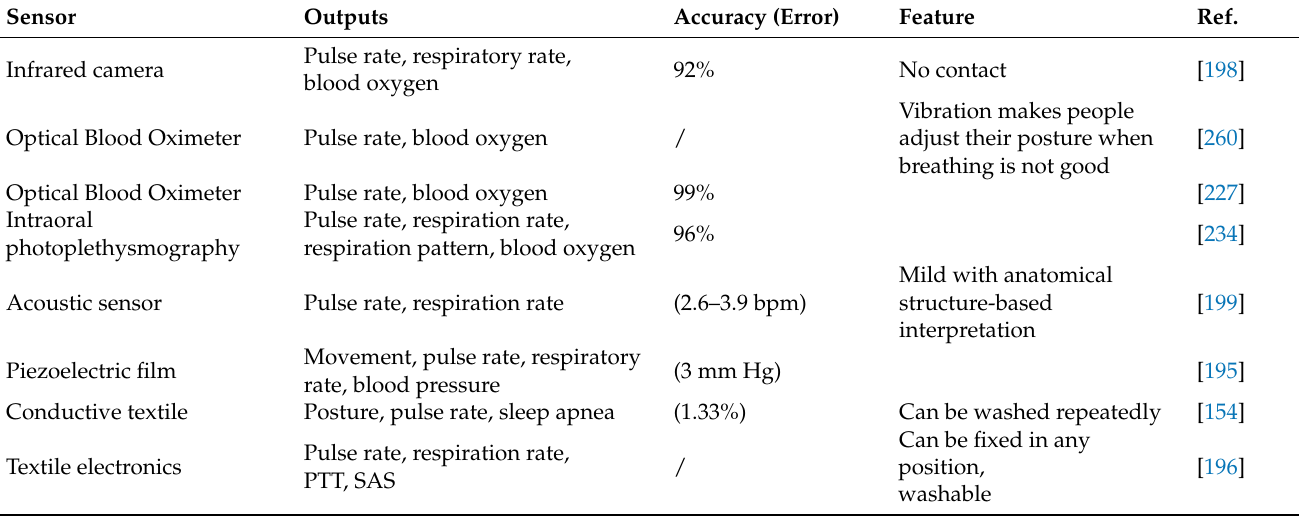
Table 4. Table for multi-signal detection based on a single